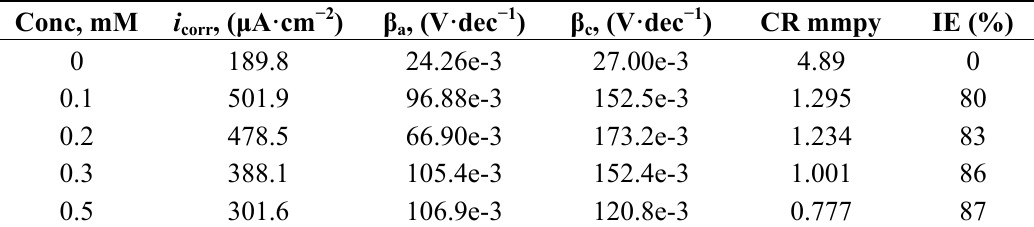
Table 3. Electrochemical frequency modulation (EFM) parameters for mild steel in 1.0 M HCl with various concentrations of DMPO at 30